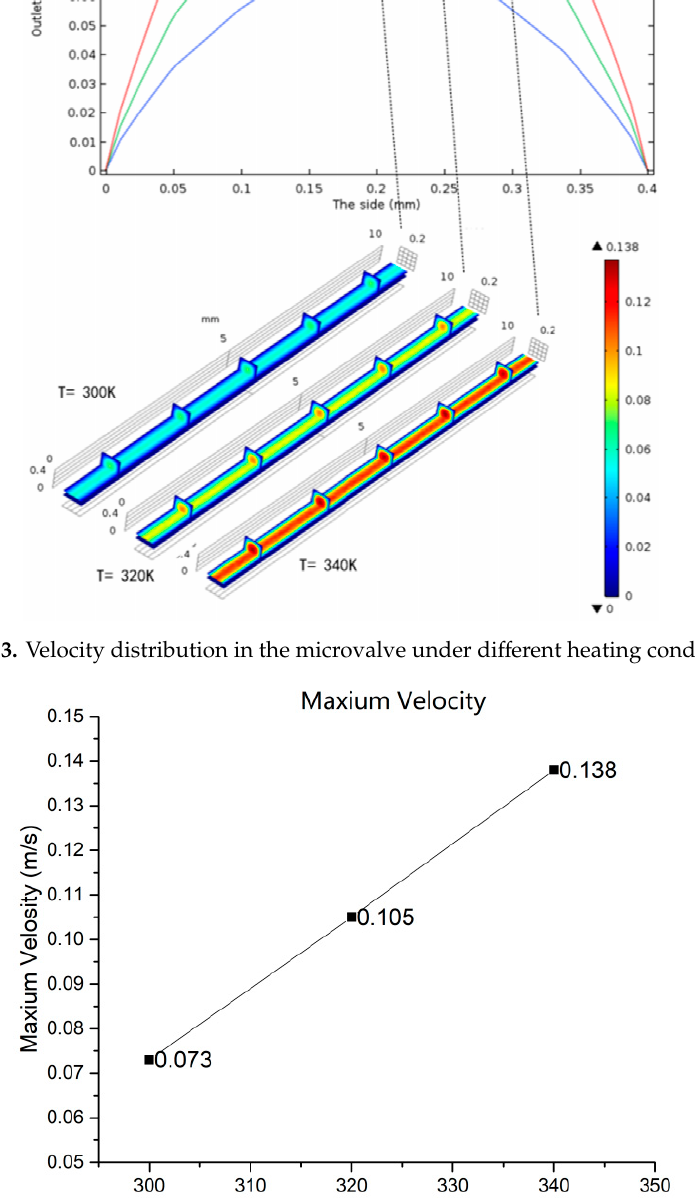
Figure 4. Maximum outlet velocity variation with heat temperatures.